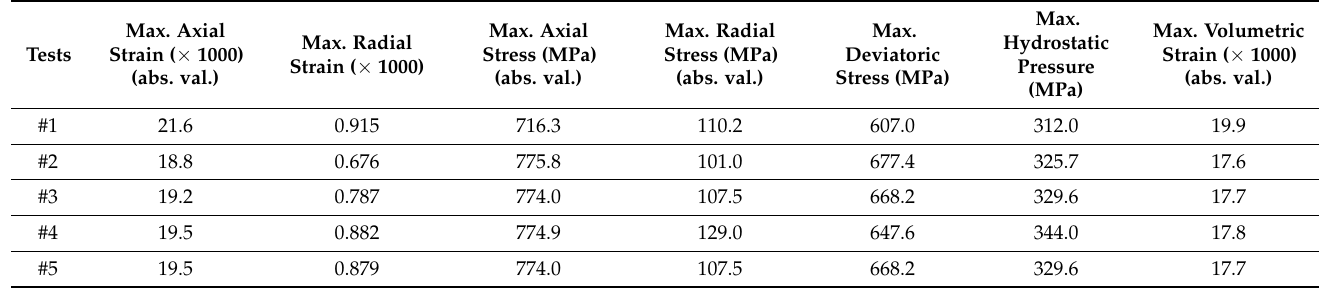
Table 4. Maximum values of sample radial µ -strain, axial stress, radial stress, deviatoric stress, hydrostatic pressure, and volumetric strain in quasioedometric compression tests.